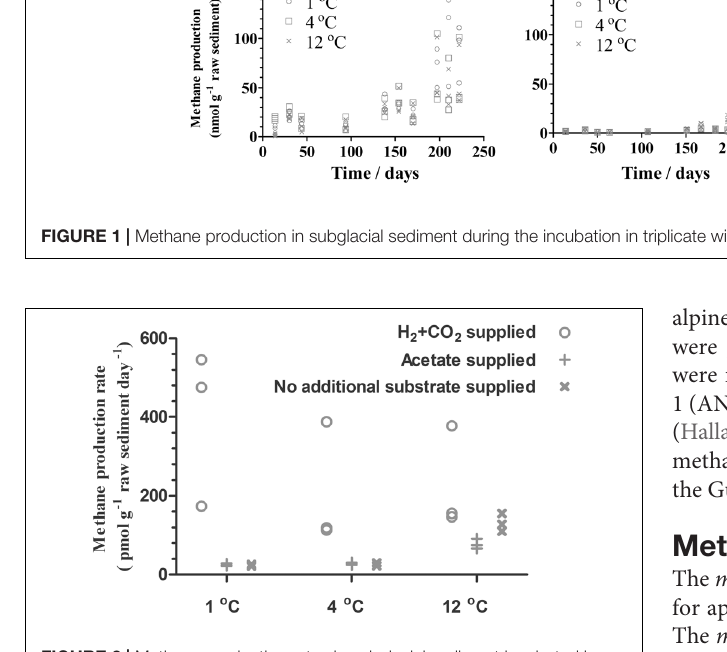
FIGURE 2 | Methane production rates in subglacial sediment incubated in triplicate at different temperatures with different